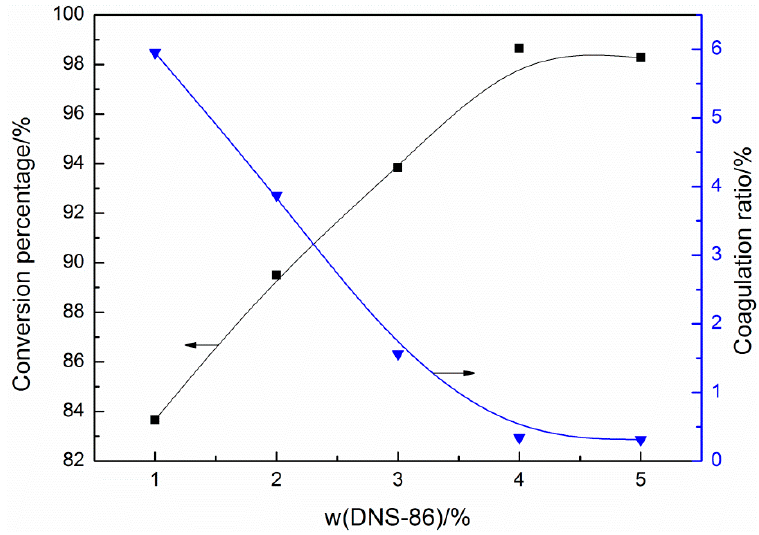
Figure 2. Effect of the DNS-86 amount on conversion rate and coagulation ratio. Figure 2. E ff ect of the DNS-86 amount on conversion rate and coagulation ratio.